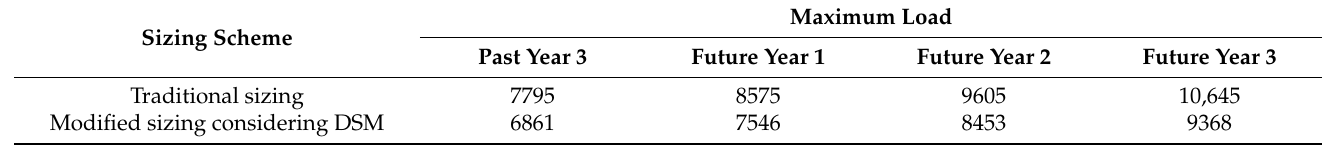
Table 5. Power demand forecasting and its corresponding modified results considering DSM (MW).